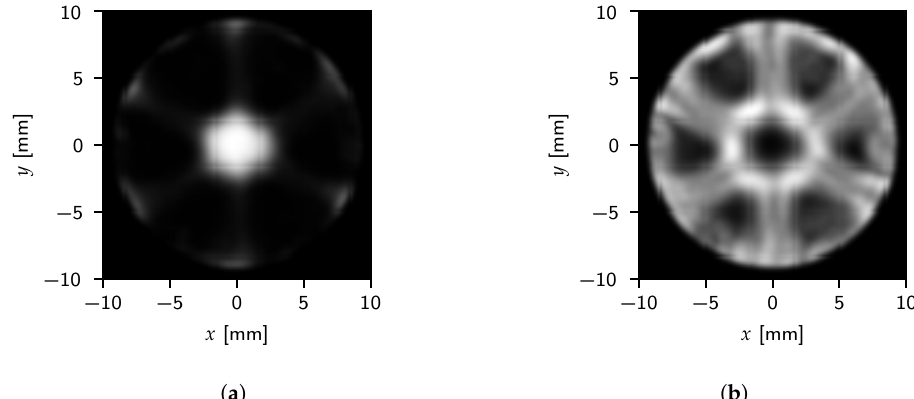
Figure 15. Time-averaged results for the cylindrical outlet using ( a ) density and ( b ) color gradient magnitude. The density and color gradient magnitude image intensity maps to a range of 0 to 220 kg/m 3 and 0 to 0.09 m 2 /kg,